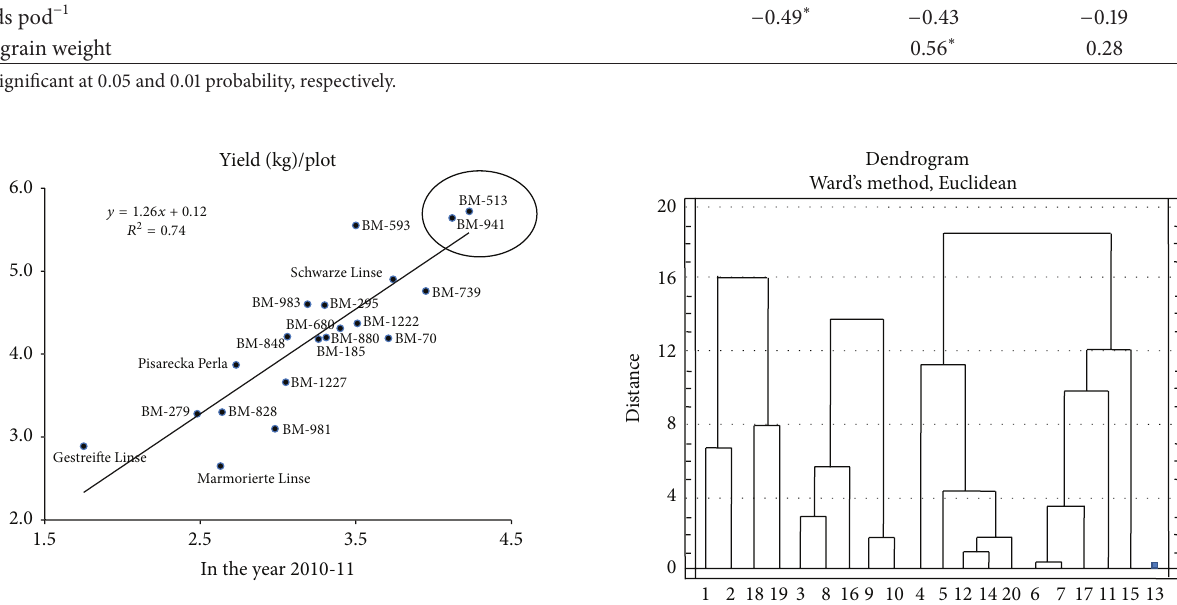
Figure 1: Yield of 20 lentil genotypes in ecological farming in two growing seasons (2010-11 and 2011-12). Figure 2: Dendrogram based on Euclidean distance, summarizing the data on differentiation among 20 lentil genotypes according